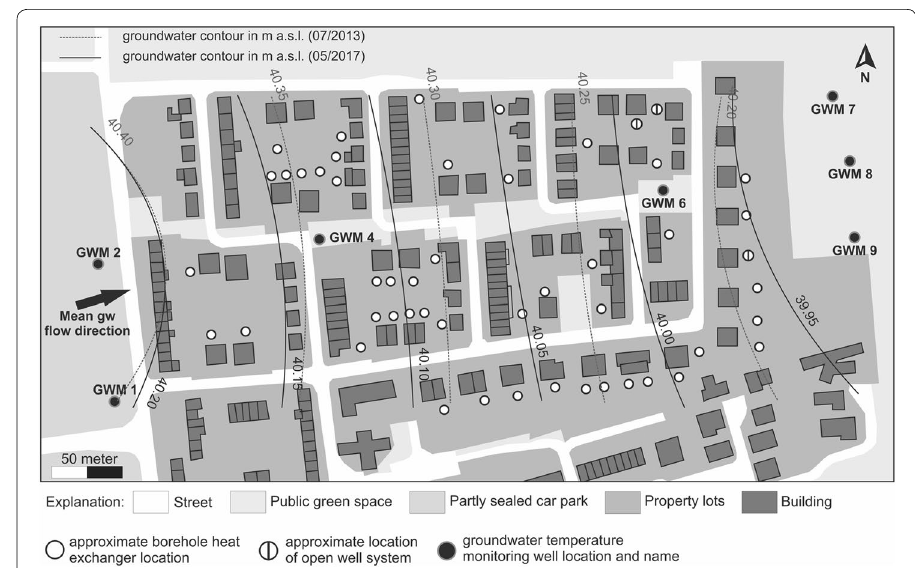
Fig. 1 Overview of the test site with locations of groundwater temperature-monitoring wells and shallow geothermal